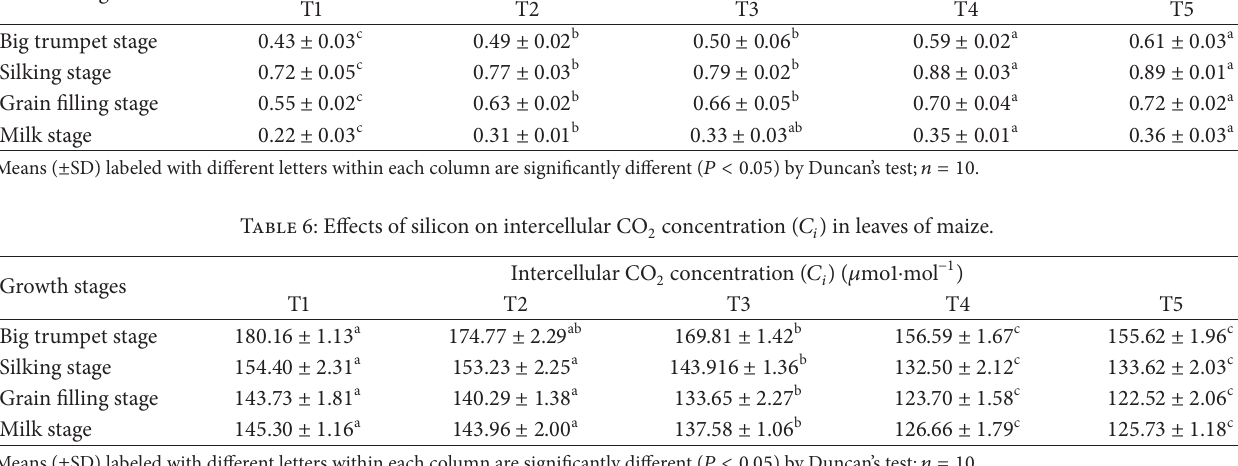
Table 5: Effects of silicon on stomatal conductance ( 𝑔 𝑠 ) in leaves of maize.